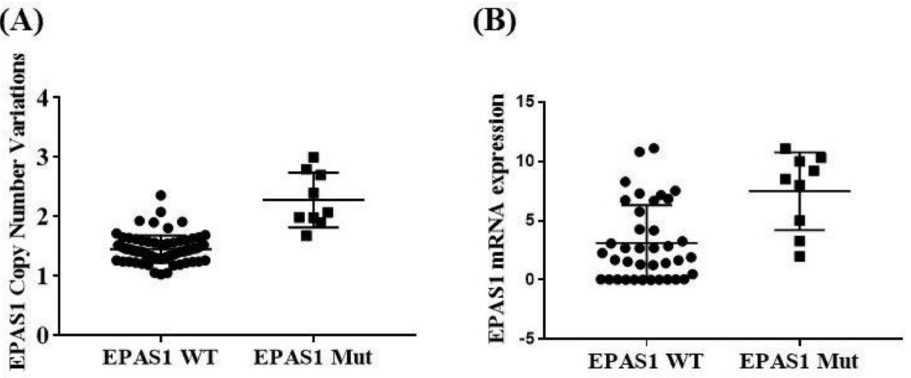
Figure 6. Association of EPAS1 DNA number alteration and mRNA expression with